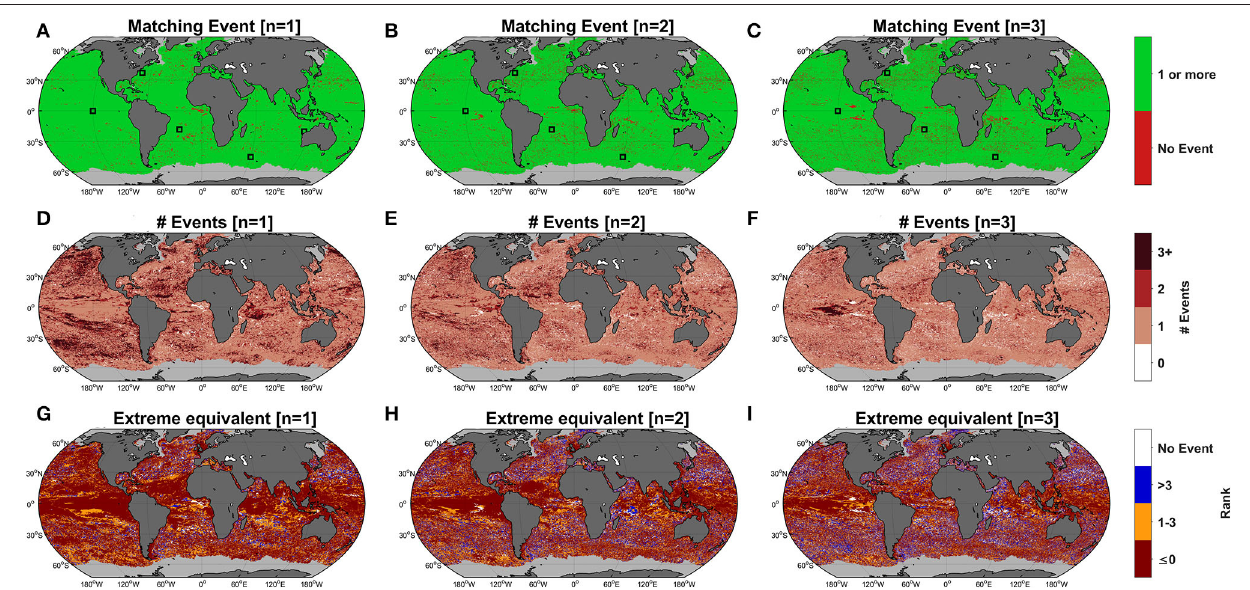
FIGURE 9 | Surface signature of upper ocean 3 ( n = 1–3, from left to right) most extreme MHWs. (A–C) Locations where the nth most extreme upper ocean MHW events coincided with a surface MHW event. Pixels where at least one surface MHW event period (e.g., start to end of MHW) intersected with the upper ocean MHW period were defined as matching (green). (D–F) Number of surface MHWs intersecting with the nth most extreme MHW event. Pixels where the nth most extreme upper ocean MHW did not coincide with any surface MHW was plotted in white. (G–I) Rank difference of cumulative intensity sum of surface MHWs coinciding with the nth most extreme upper ocean MHW, relative to all surface MHWs identified during the 1984-2014 period (Surface Extreme Equivalent). A value of 0 or less signifies that the surface signature MHW was at least as extreme. In contrast, a value of 1 signifies that the surface signature was 1 rank (relative to n ) less extreme. Surface MHWs were identified according to the Hobday et al. (2016) definition. Grid points contaminated by sea-ice were excluded from the analysis (gray shading). The black boxes denote the location of pixels chosen in Supplementary Figure 3 .